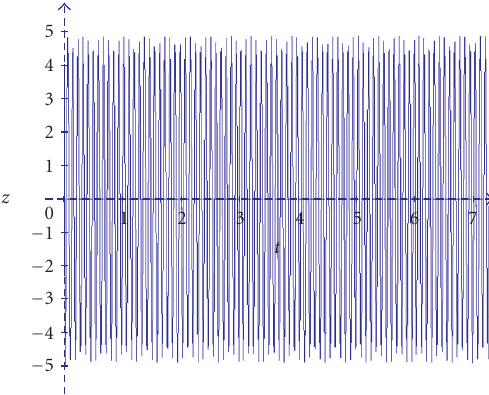
Figure 6.6 . Bounded solution of (5.2) in the point E (544 . 5,40), a 0 = 4.